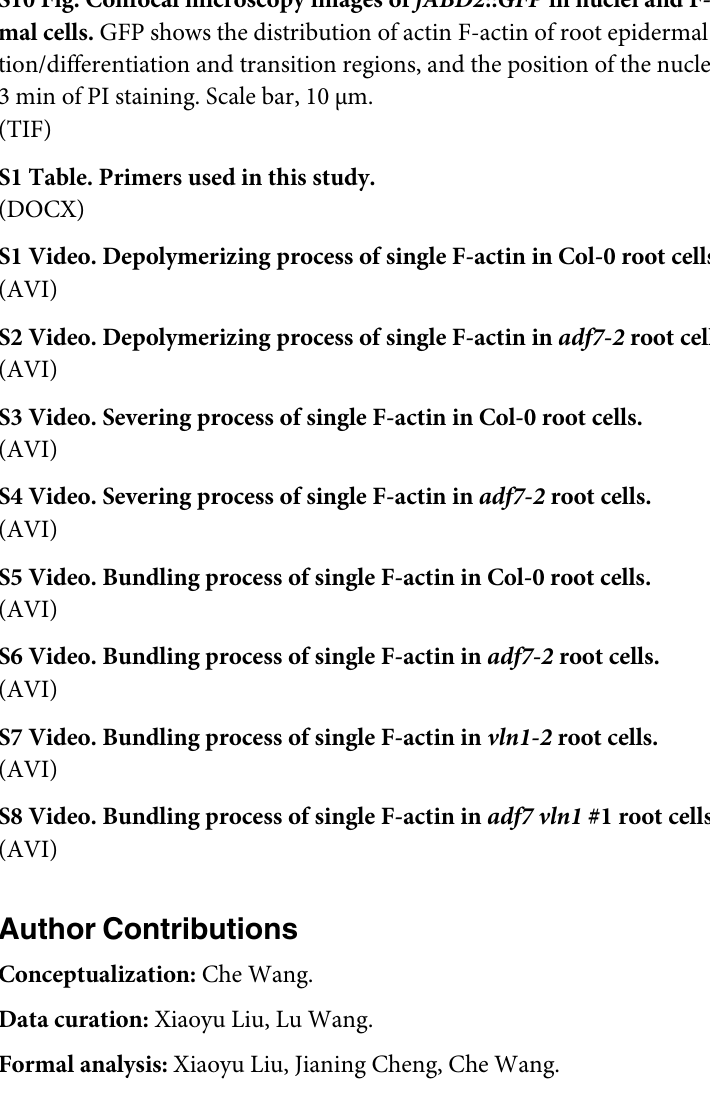
S10 Fig. Confocal microscopy images of fABD2 :: GFP in nuclei and F-actin of root epider- mal cells. GFP shows the distribution of actin F-actin of root epidermal cells in the elonga- tion/differentiation and transition regions, and the position of the nucleus was observed after 3 min of PI staining. Scale bar, 10 μ m. S1 Table. Primers used in this